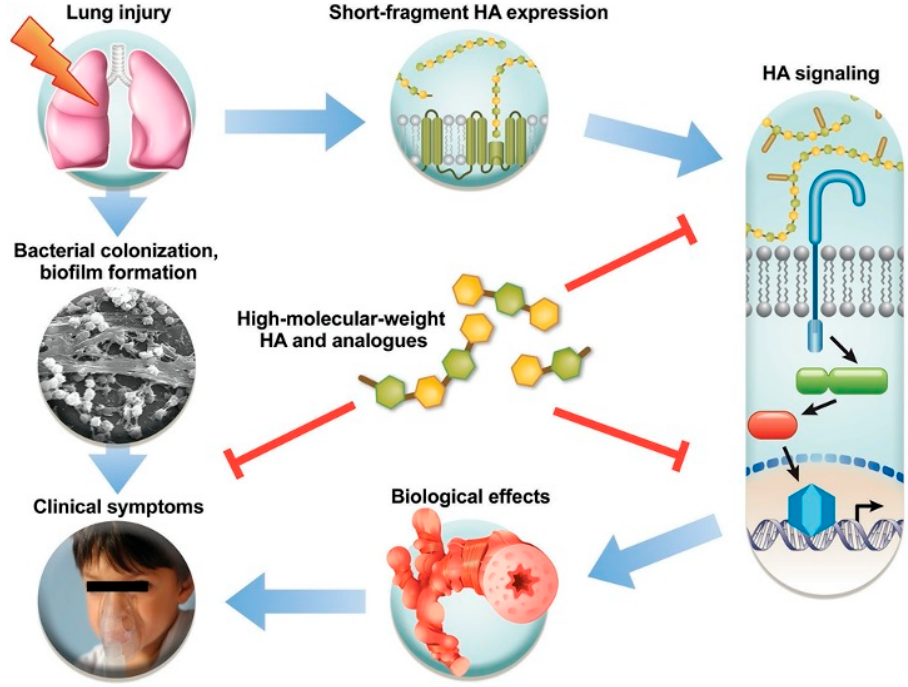
Figure 1. Effects of short-fragment hyaluronic acid (HA) on a lung injury (from Garantziotis S et al. The role of hyaluronan in the pathobiology and treatment of respiratory disease. Am J Physiol Lung Cell Mol Psysiol 2016; 310:L785–L795).